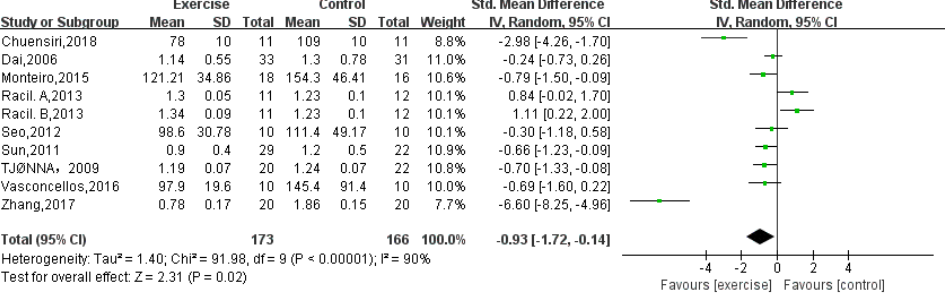
Figure 6. Forest plot of TG.